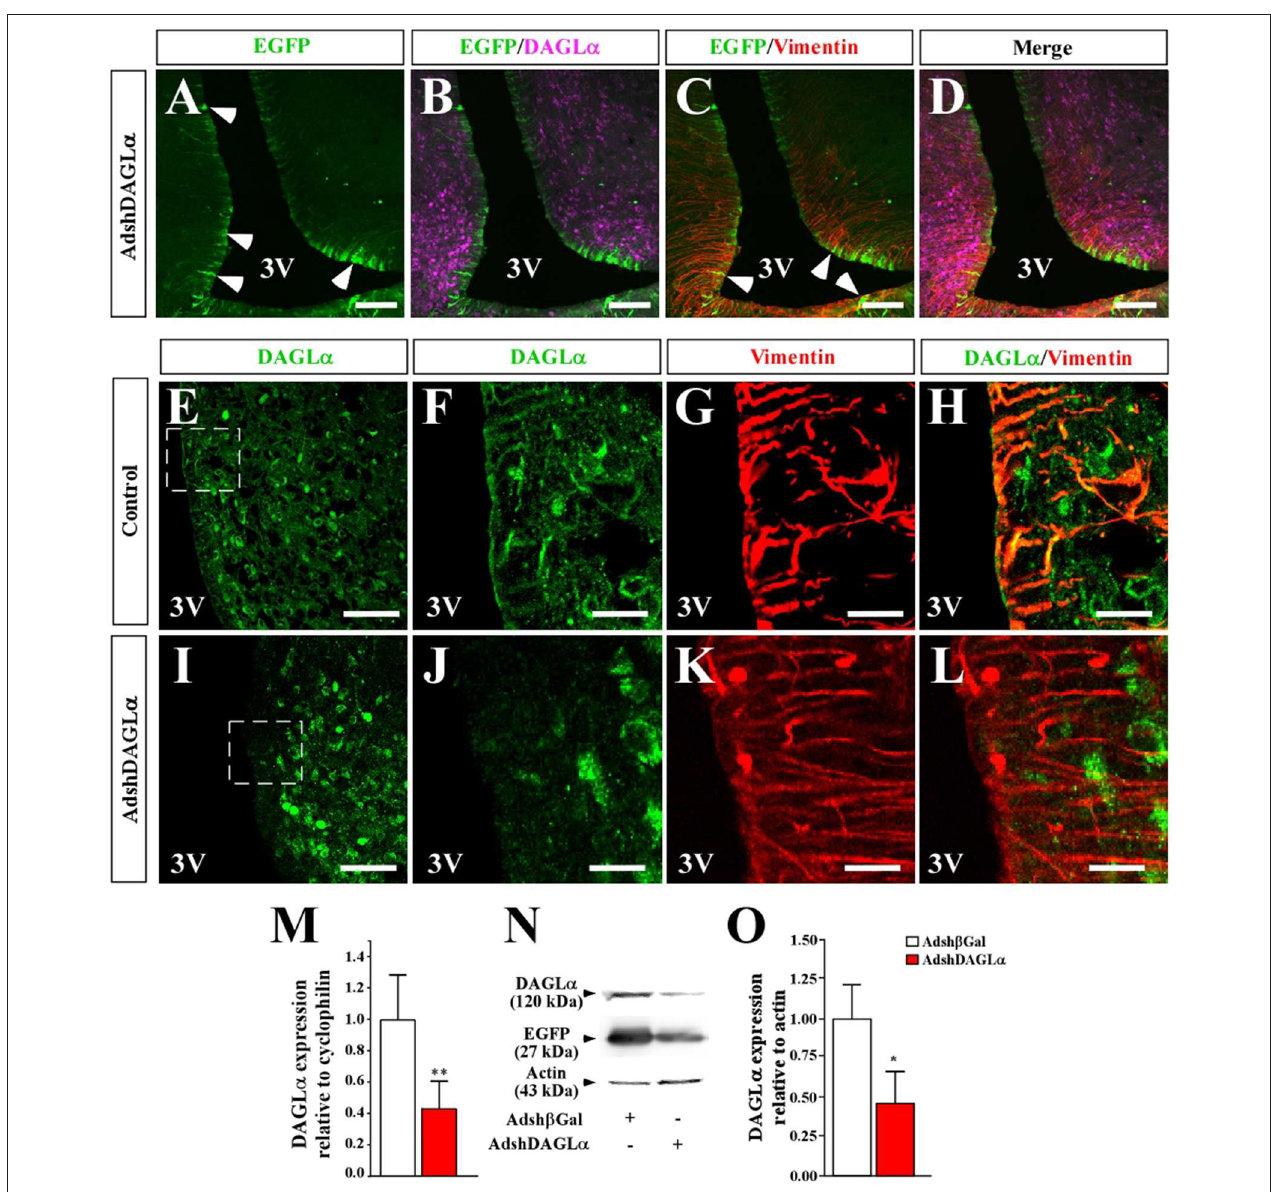
FIGURE 4 | Effect of i.c.v-injected AdshDAGL α in the 3V on the expression of hypothalamic DAGL α . (A–D) Frontal sections of the hypothalamus (40 µ m) in which the EGFP fluorescence ( A–D , green), immunoreactivity for DAGL α ( B,D , purple) and vimentin ( C,D , red) are shown in cells transduced with AdshDAGL α . (E–H) High magnification images showing immunoreactivity for DAGL α ( E,F,H , green) and vimentin ( G,H , red) in control animals. (I–L) High magnification images showing immunoreactivity for DAGLa ( I,J,L , green) and vimentin ( K,L , red) in AdshDAGL-transduced rats. Inset in (I) compared with inset in (E) show the decrease in reactivity for DAGL α in the ventricular region and not in the parenchymal region. (M) mRNA quantification for DAGL α by qRT-PCR ( n = 6). (N) Representative Western blot for all conditions evaluated in (B) ( n = 4). (O) Western blot quantification. Bars represent average ± S.D. Bar size (A–D) 200 µ M, (E–L) 50 µ m. * p < 0.05, ** p <